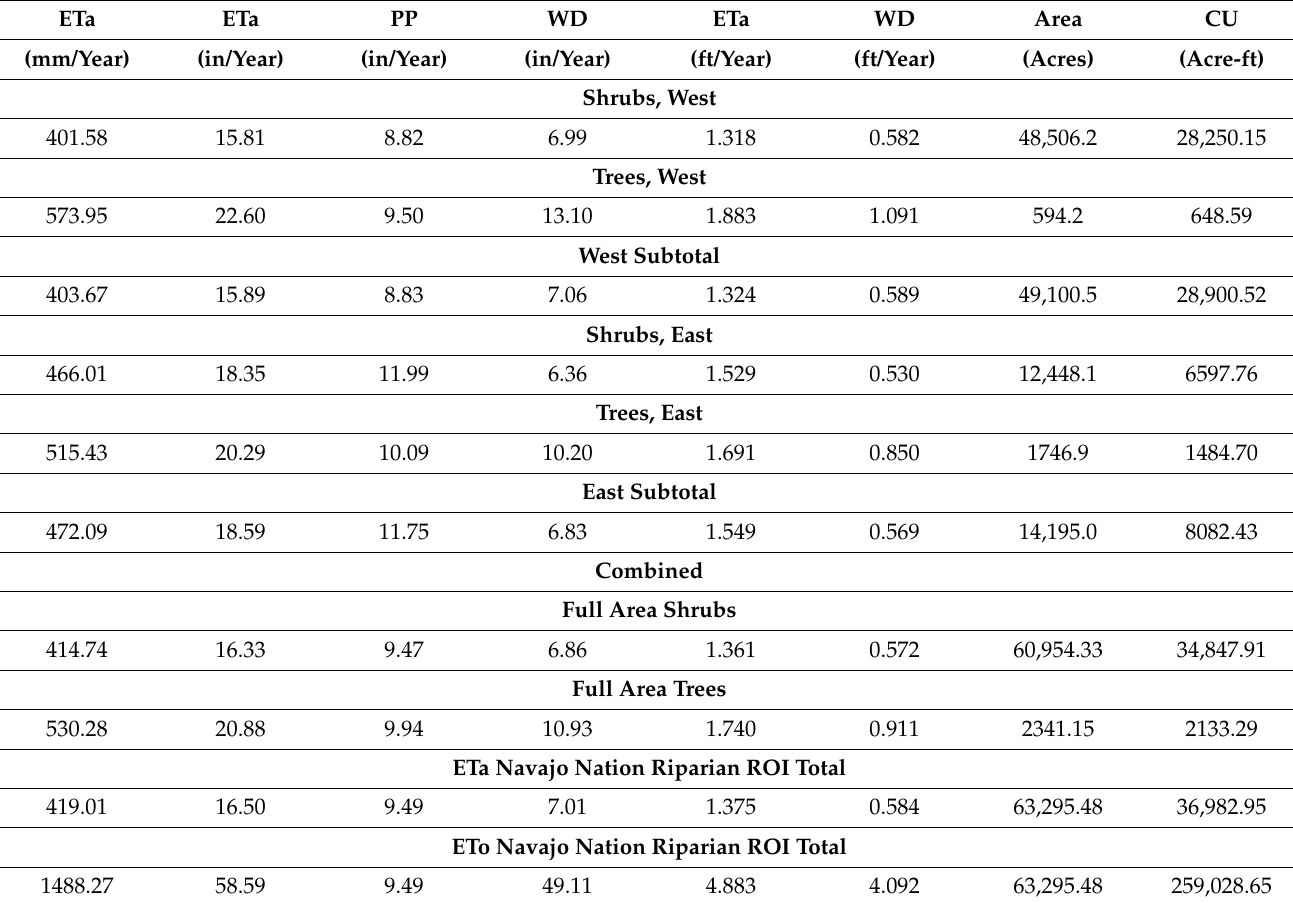
Table 7. Final water metric results for the riparian ROI showing the rasterized ‘best-approximation’ estimate of the mean data from 2014 to 2020 using gridded Daymet weather data (1 km) and Landsat (30-m) to derive ETa (mm, in, ft), PP (in), WD (in, ft) and ETo (mm, in, ft) (last row); the CU (acre-ft, last column) is calculated by ground area for shrubs, trees, and total riparian